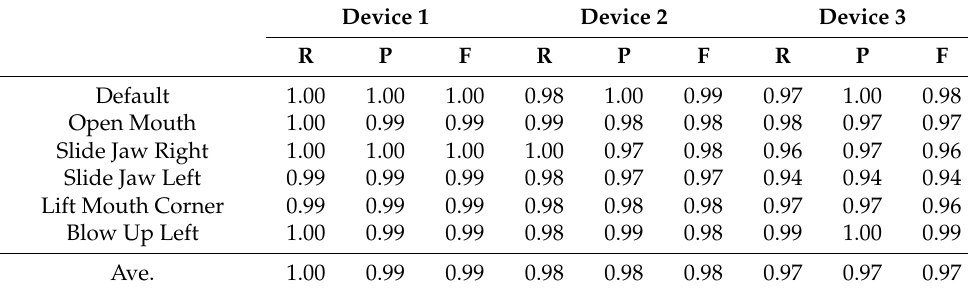
Table A3. The results of a single device for each gesture in Evaluation 2.